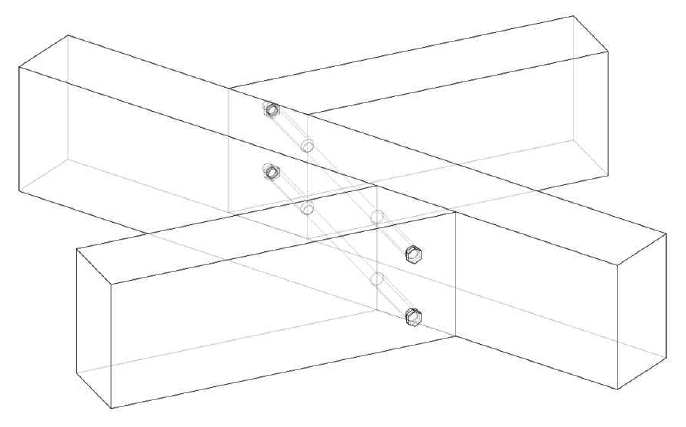
Figure 5. The original Zollinger joint. Lamellae are spaced apart by three widths of the lamella.